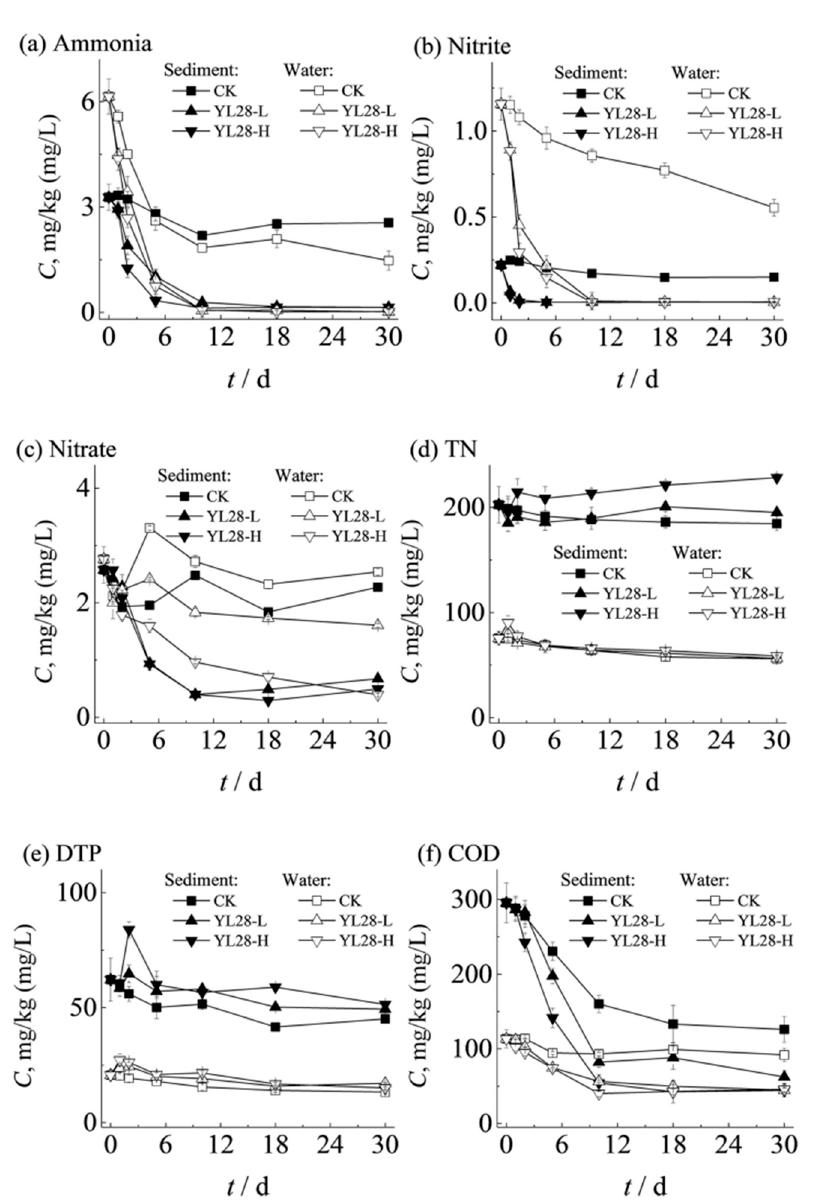
Figure 1. Effects of supplements of YL28 on the environmental factors of sediment and water column, respectively. The addition time of YL28 is on 0, 6th, 12th, 18th days, respectively. The data on 0 d is the determination value of samples without YL28 addition. CK, control group; YL28-L and YL28-H represent a low and high dose addition of YL28 into water with a concentration of 3.0 × 10 6 cells/mL and 1.5 × 10 8 cells/mL, respectively. ( a ) Comparison of ammonia concentration affected by YL28 additions. ( b ) Comparison of nitrite concentration affected by YL28 additions. ( c ) Comparison of nitrate concentration affected by YL28 additions. ( d ) Comparison of TN concentration affected by YL28 additions. ( e ) Comparison of total phosphate (DTP) concentration affected by YL28 additions. ( f ) Comparison of chemical oxygen demand (COD) affected by YL28 additions. Significant difference: p < 0.05.